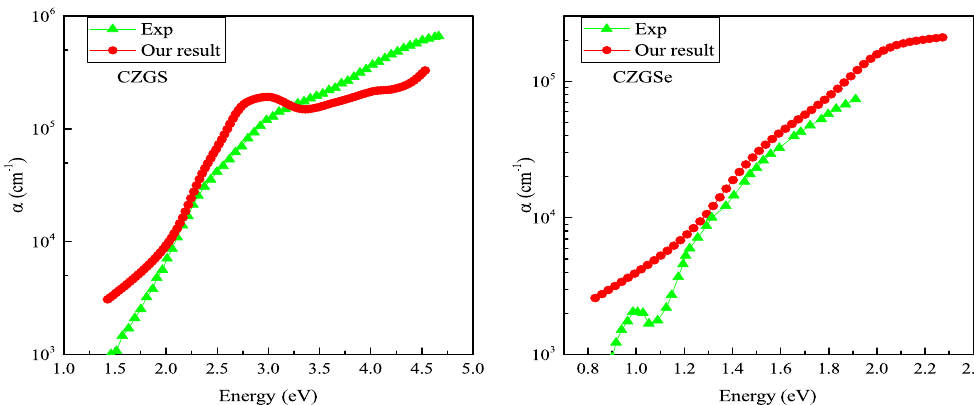
Figure 11. Experimental measurements of the optical absorption coefficient of CZGS [43] ( left ) and CZGSe [25] ( right ) are compared with those calculated from DFT + U